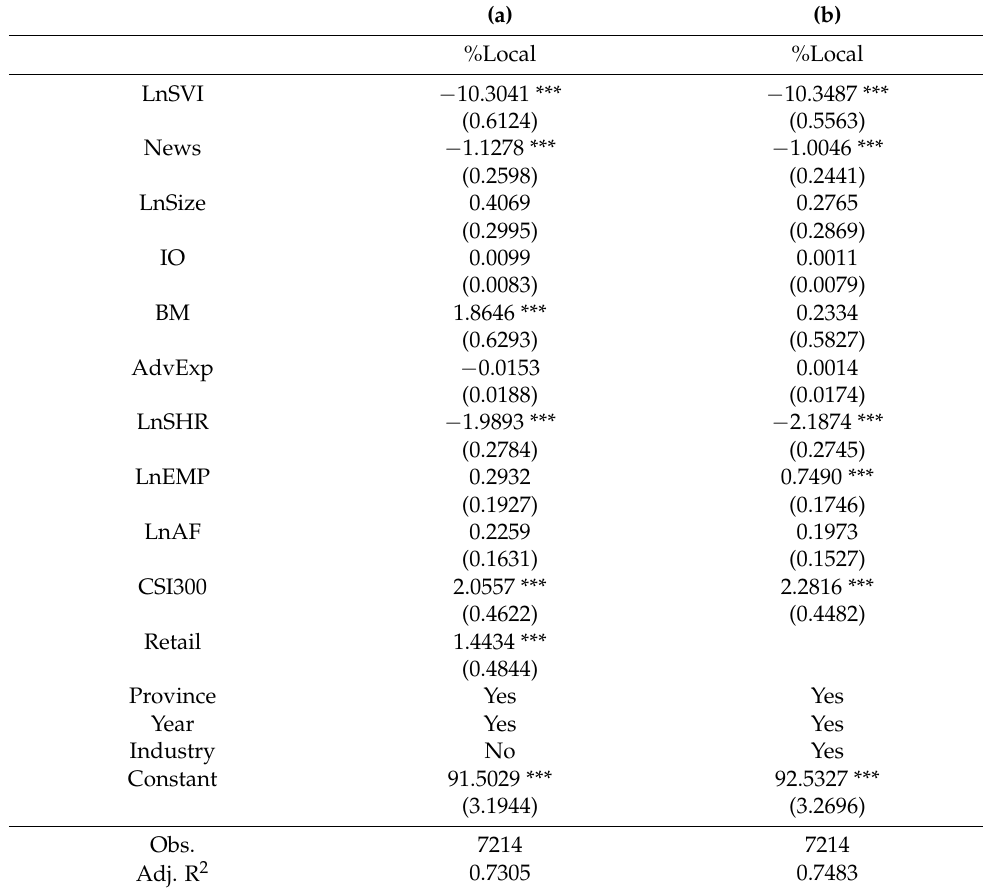
Table 4. Local Attention in Search and Firm